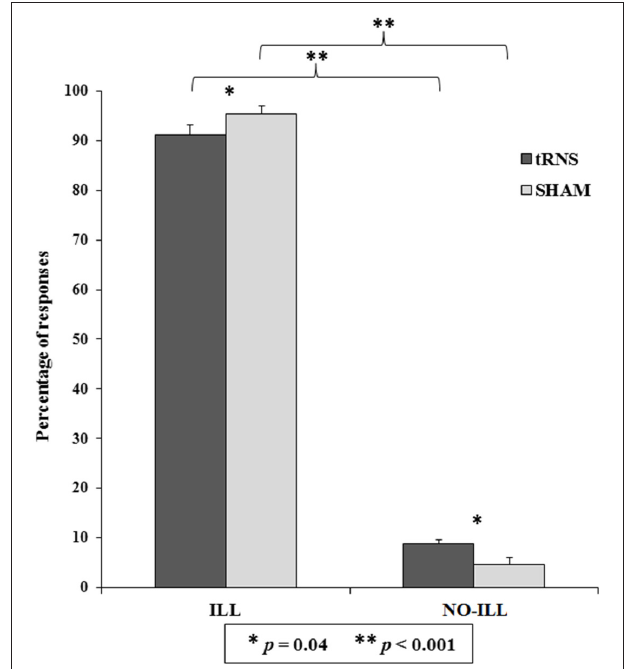
FIGURE 3 | Percentage of responses indicating whether the sequence of sounds was perceived as the Deutsch’s illusion (ILL) or in a non-illusory manner (NO-ILL), during the real stimulation (tRNS) and during the control condition (Sham). Asterisks show the significant comparisons and bars represent standard